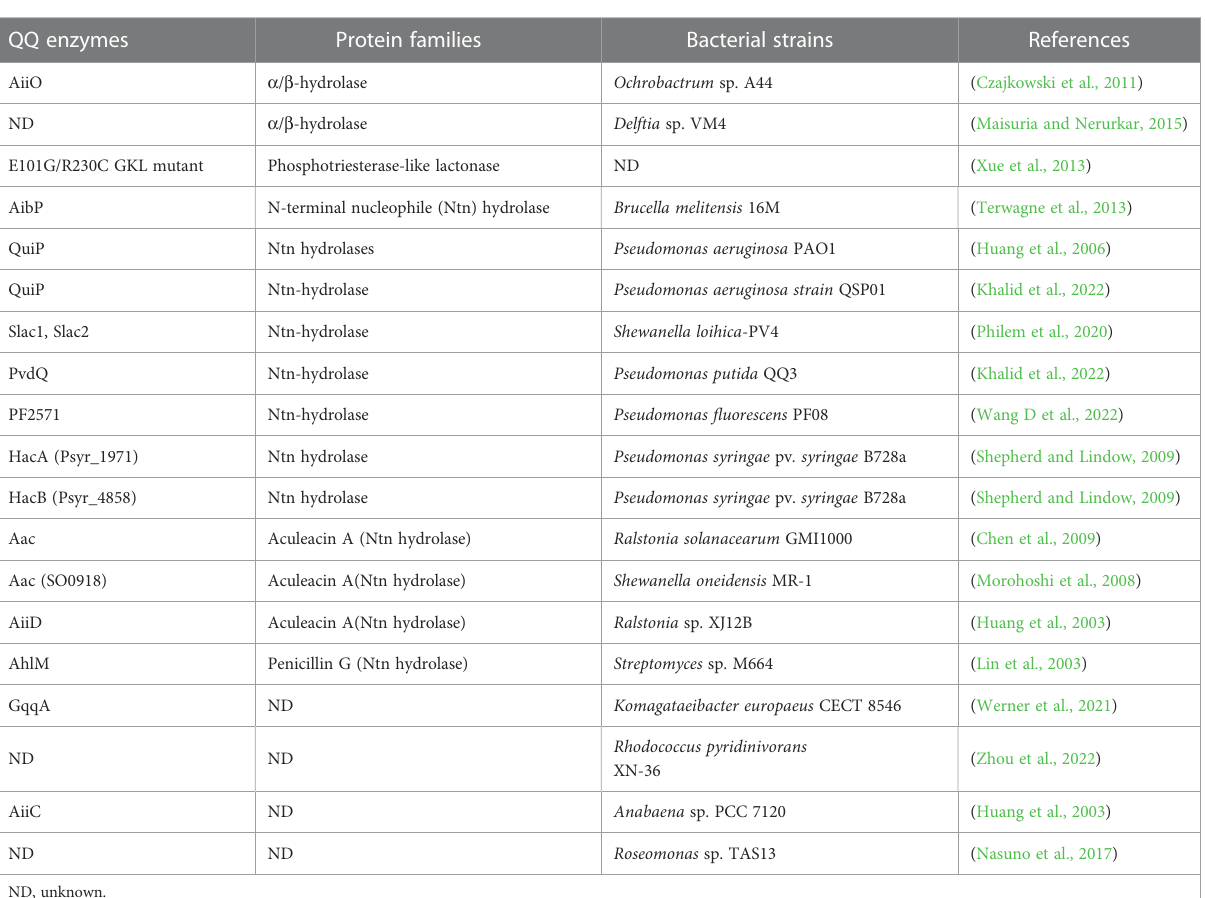
TABLE 1 Reported AHL acylases isolated from QQ bacterial